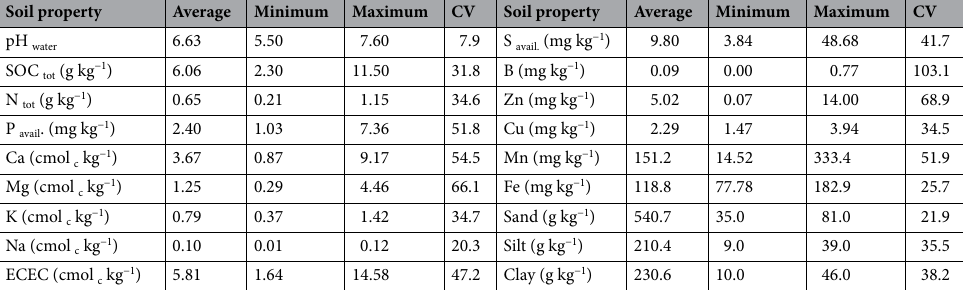
Table 1. Selected physico-chemical properties of top soil (20 cm) layer in the experimental fields.